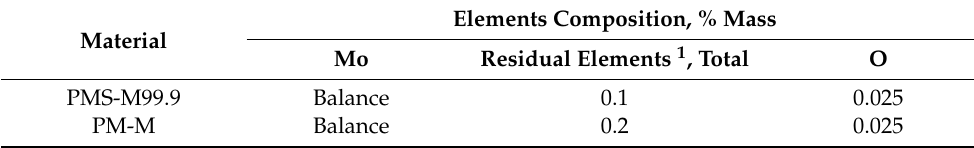
Table 3. The properties of Mo powders PMS-M99.9 and PM-M. Material